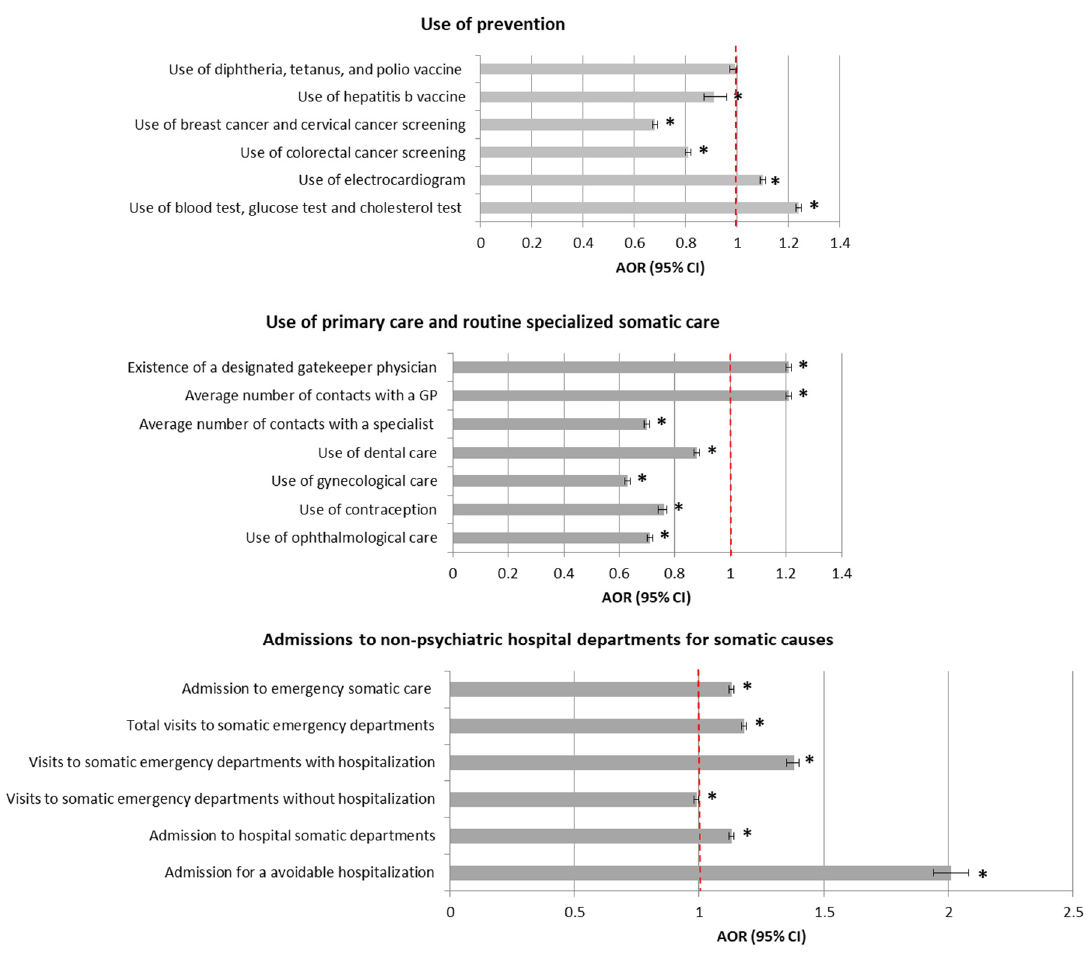
Figure 3. Multivariate analysis of general somatic care use in patients with SMI compared with matched controls without SMI. * Statistically significant.